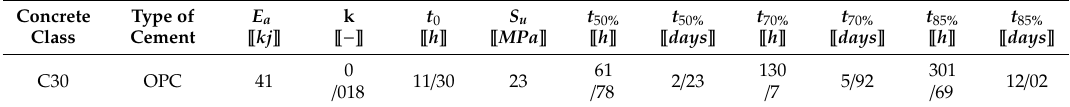
Table 1. Constant coe ffi cient and activation energy used.